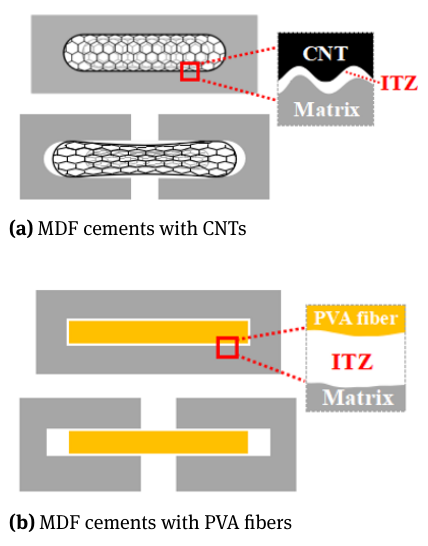
Figure 14: Energy dissipation mode of MDF cements with (a) CNTs and (b) PVA fibers.